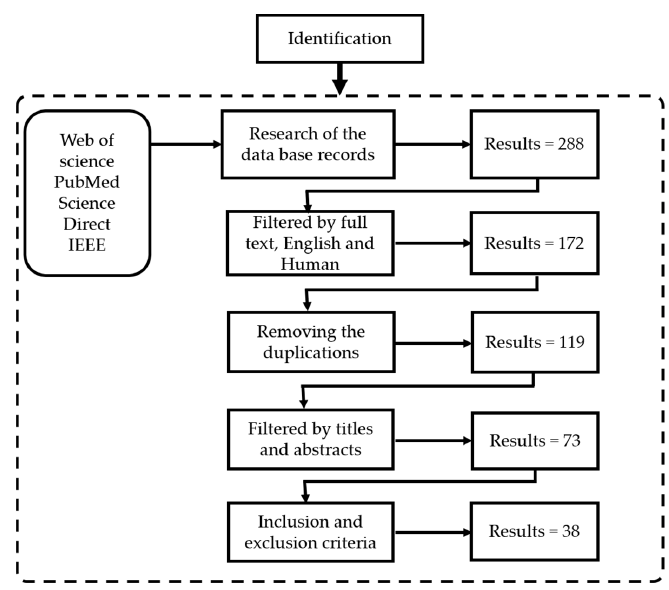
Figure 2 . The search strategy. Figure 2. The search strategy.